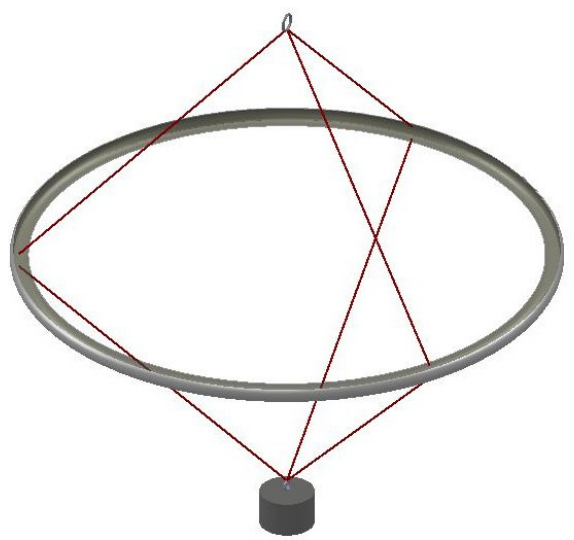
Fig. 8. Ring-shaped brush used for cleaning the inside of the enclo- sure walls. The brush is pulled downwards by a weight attached by ropes below the ring and pulled upwards manually by a rope run over a pulley fixed above the centre of the enclosure bags under- neath the hood. In follow-up experiments the brush was replaced by a double-bladed